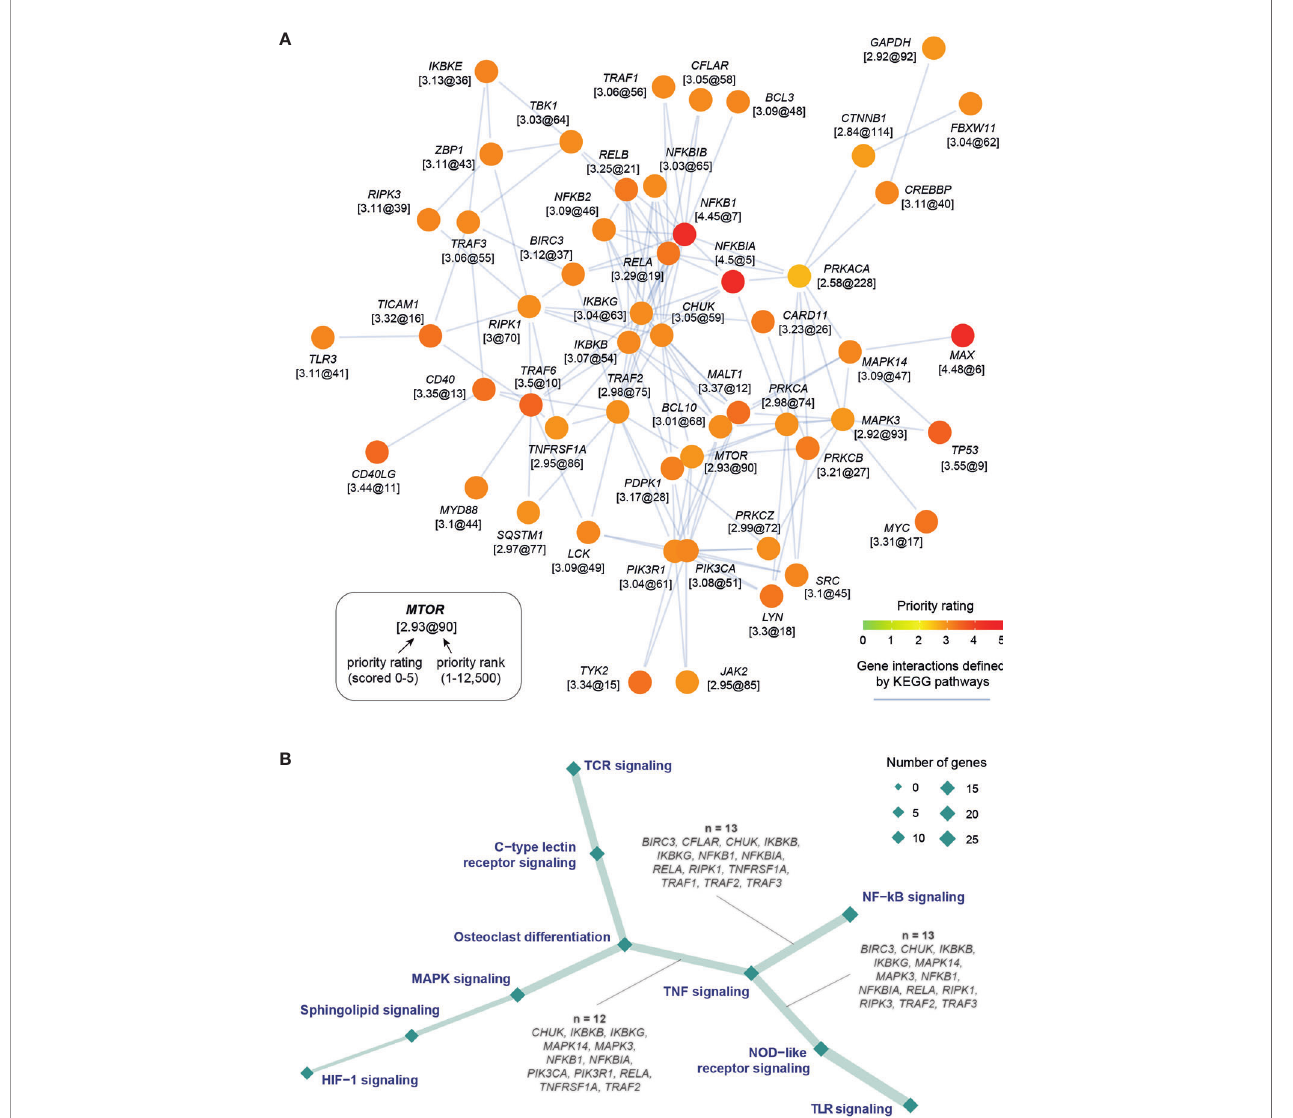
FIGURE 3 | Target pathway crosstalk identi fi ed in kidney stone disease. (A) Gene-centric representation of the crosstalk, with nodes for genes and edges for interactions between nodes. Node are labelled by gene symbols along with the priority information (formatted as “ rating@rank ” ) and colored by priority rating. This crosstalk was identi fi ed to contain highly prioritized interconnecting genes from a network of gene interactions (obtained by merging KEGG pathways). (B) Pathway-centric representation of the crosstalk, with nodes for pathways (sized by the number of member genes) and edges for connections (the thickness proportional to the number of genes shared between two-endpoint pathways). Also labeled in the edges are shared genes between the TNF signaling and the other endpoint as